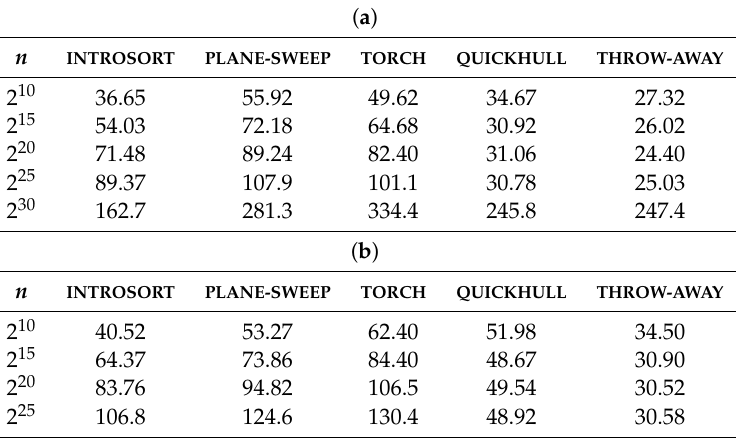
Table 5. The running time of the competitors [in nanoseconds per point] for the square data set: ( a ) Linux computer, ( b ) Windows